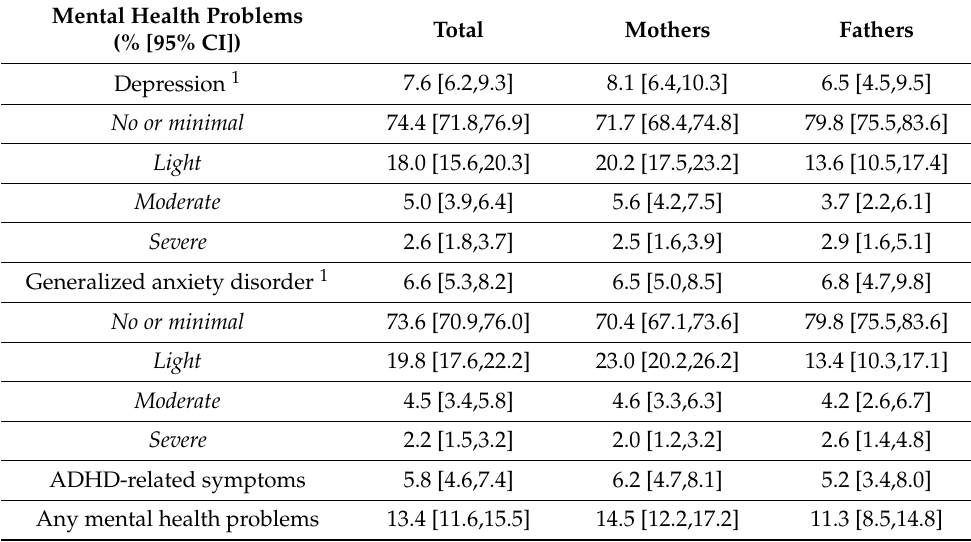
Table 5. Prevalence of mental health problems among